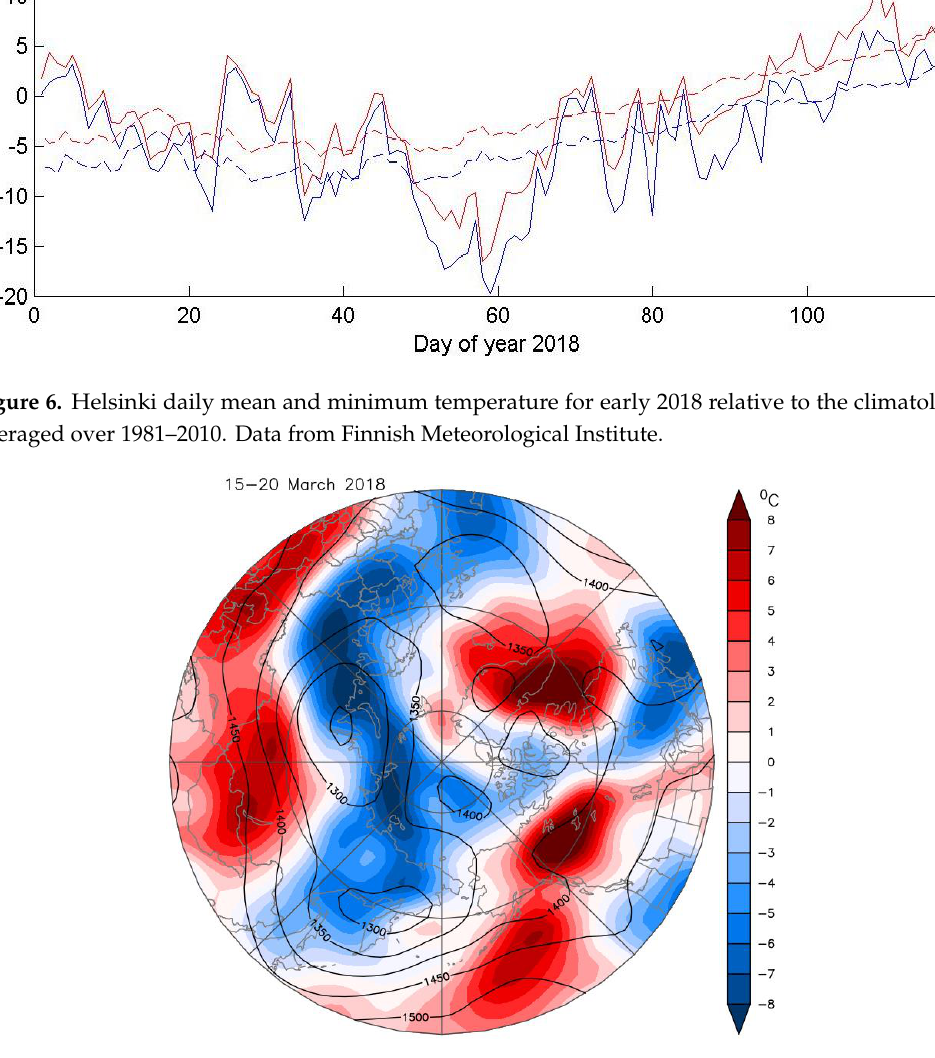
Figure 7. Composite of atmospheric 850 hPa geopotential height (contours, in units of m) and temperature anomaly fields (color shading) for 15–20 March 2018. Data are from NCEP–NCAR reanalysis.